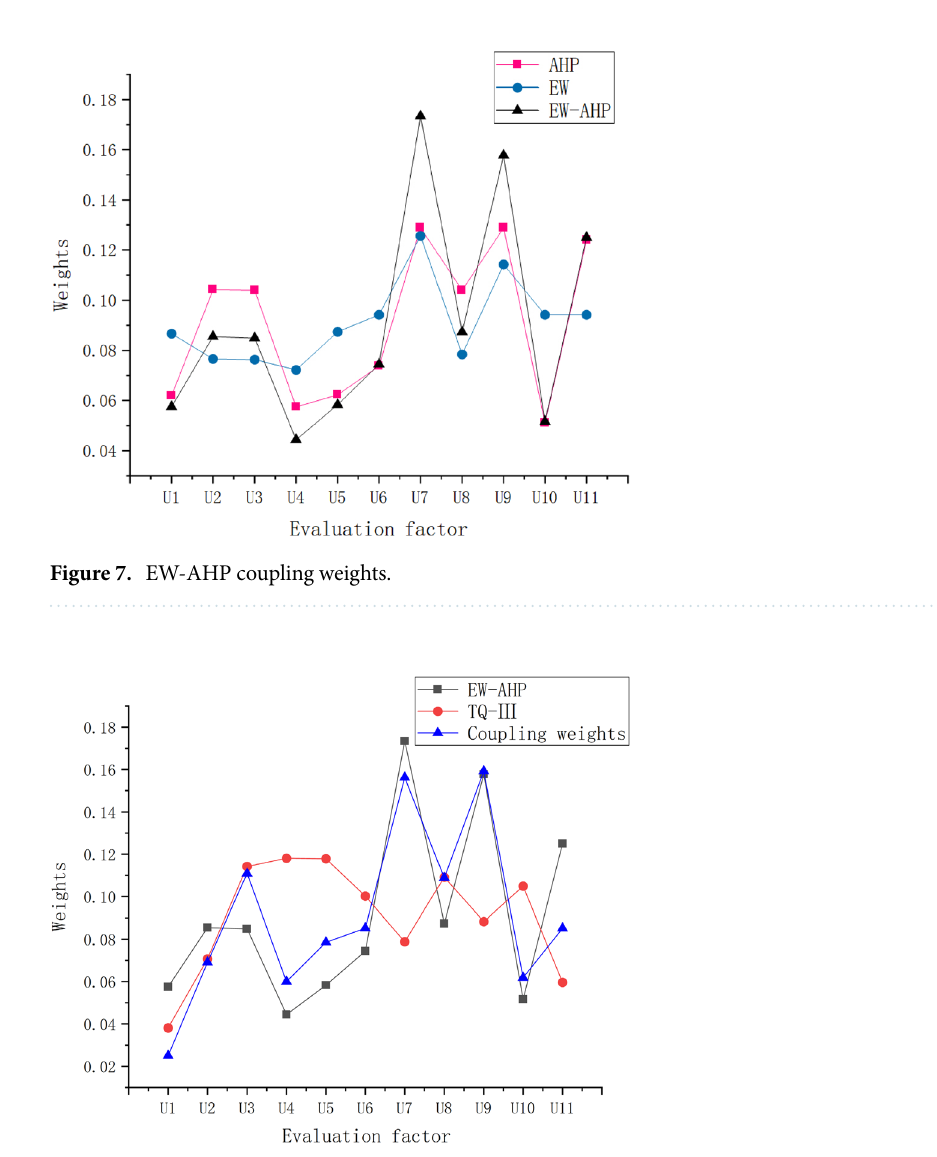
Figure 8. TQ-III and EW-AHP coupling